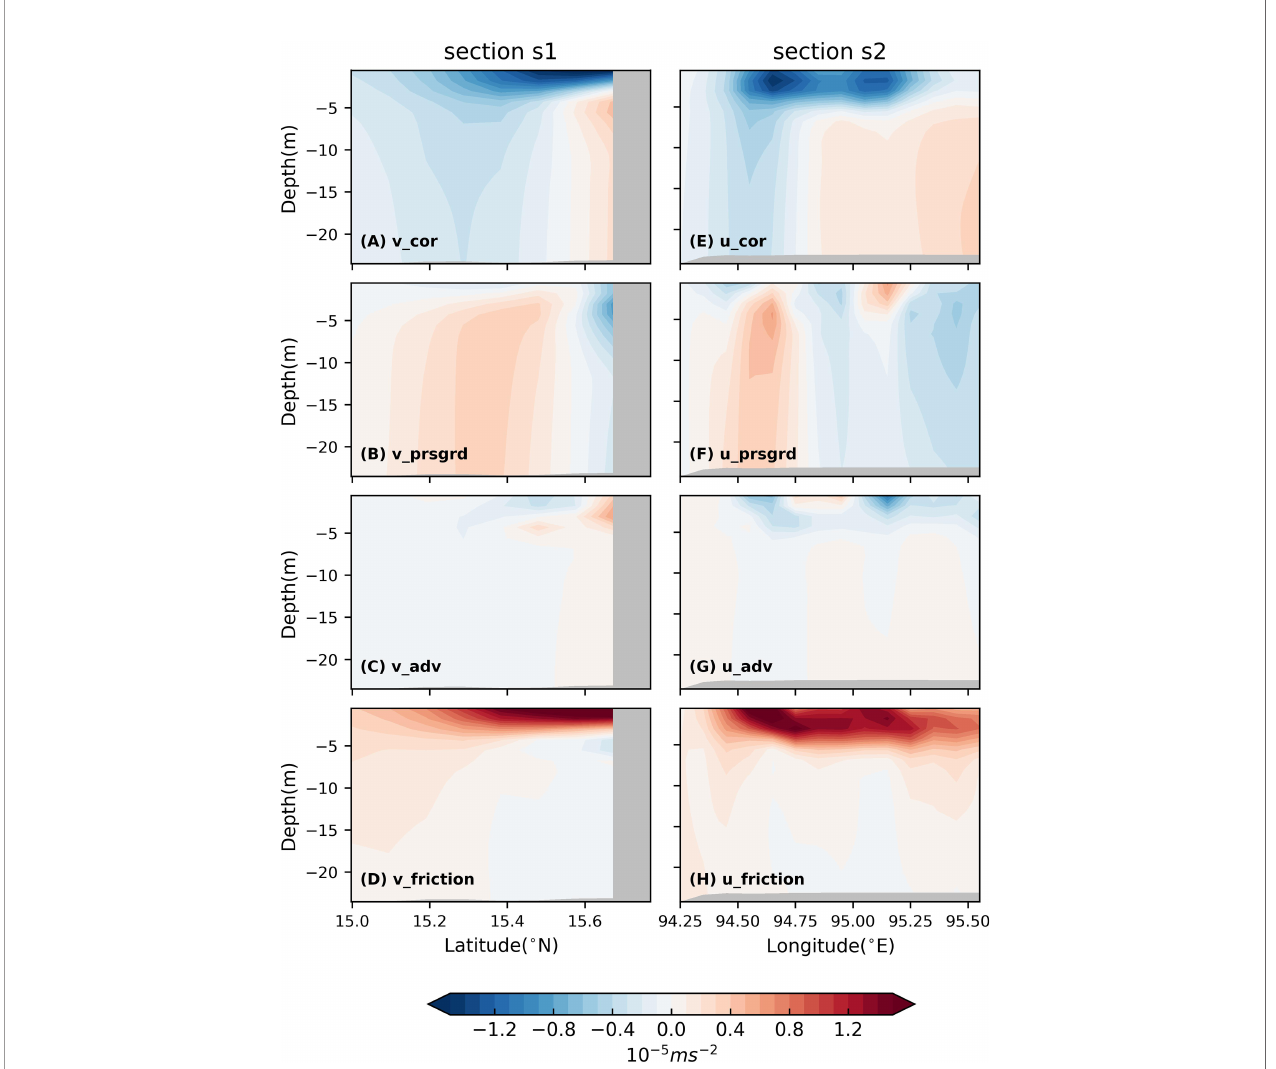
FIGURE 8 | Left Column: Distribution of meridional (v) momentum terms from experiment IRFullW for the month of August. Panels (A – D) show distribution of Coriolis, pressure gradient, horizontal advection and wind friction at the section s1. Right Column: Distribution of zonal (u) momentum terms from experiment IRFullW for the month of August. Panels (E – H) show distribution of Coriolis, pressure gradient, horizontal advection and wind friction at the section